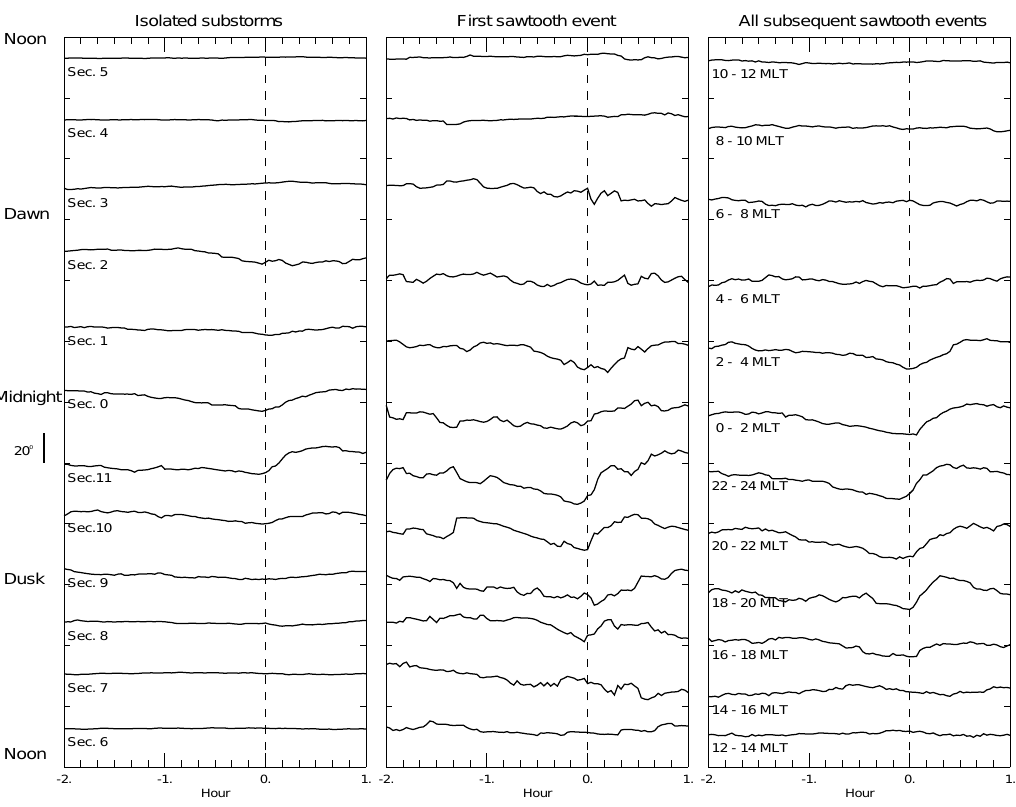
Fig. 8. Stackplot of the averaged magnetic tilt angle variations for isolated substorms (left), the first tooth in sawtooth series (middle) and all subsequent individual teeth (right). See figure caption of Fig.